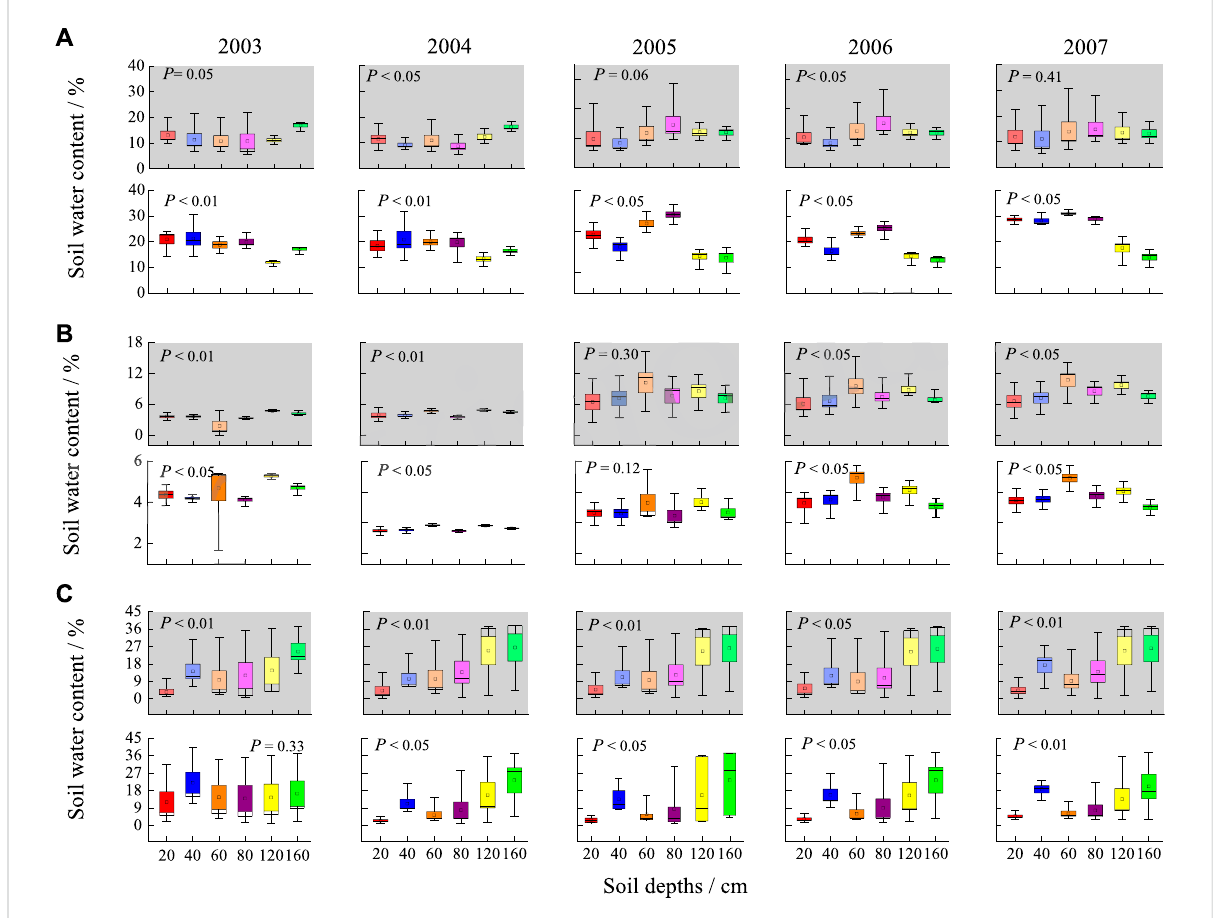
FIGURE 3 Soil moisturecontentsatvarious soildepthsinnon-growingandgrowingseasons (monthly mean± standarddeviation).Note: (A – C) represent upstream mountain vegetation zone, midstream arti fi cial shrubbery of desert oasis transition zone, and downstream desert riparian forest zone, respectively. Gray background represents non-growing season (January – April, October – November), whereas white background represents growing season (May –